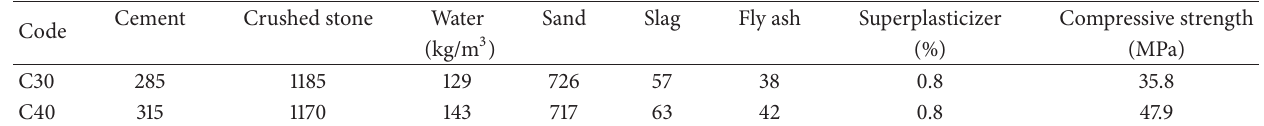
Table 1: Mixing proportion and compressive strength for pavement concrete specimens.